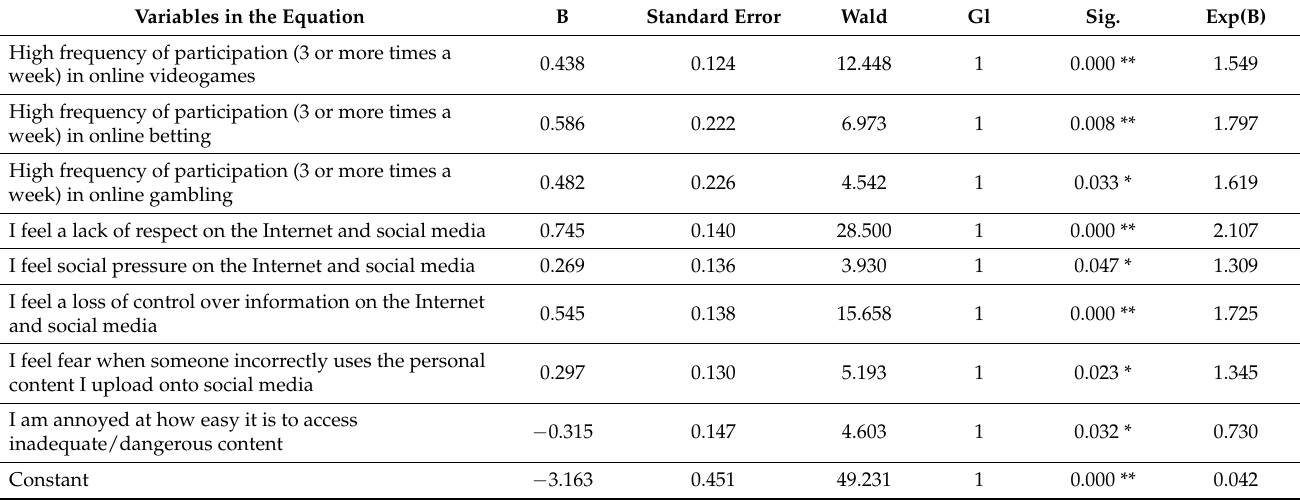
Table 5. Logistic regression model on the probability of perceiving risk or danger in online